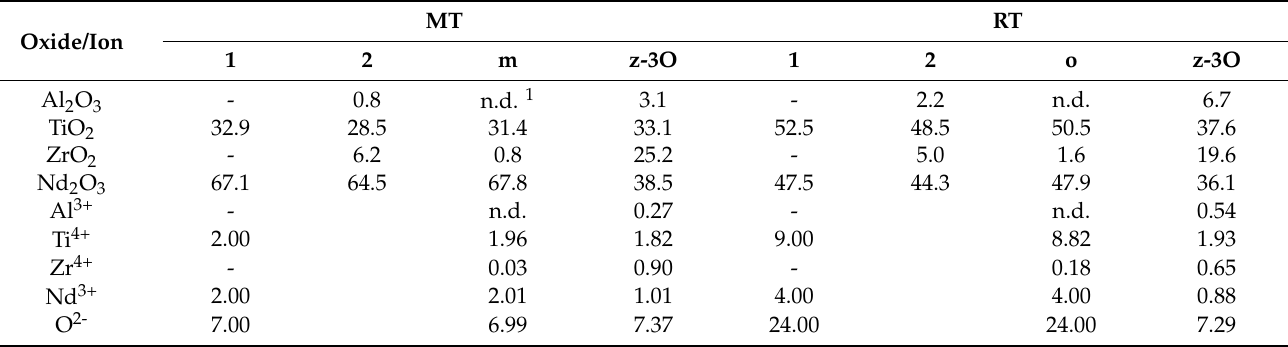
monoclinic (m) and orthorhombic (o) Nd titanates and zirconolite polytype